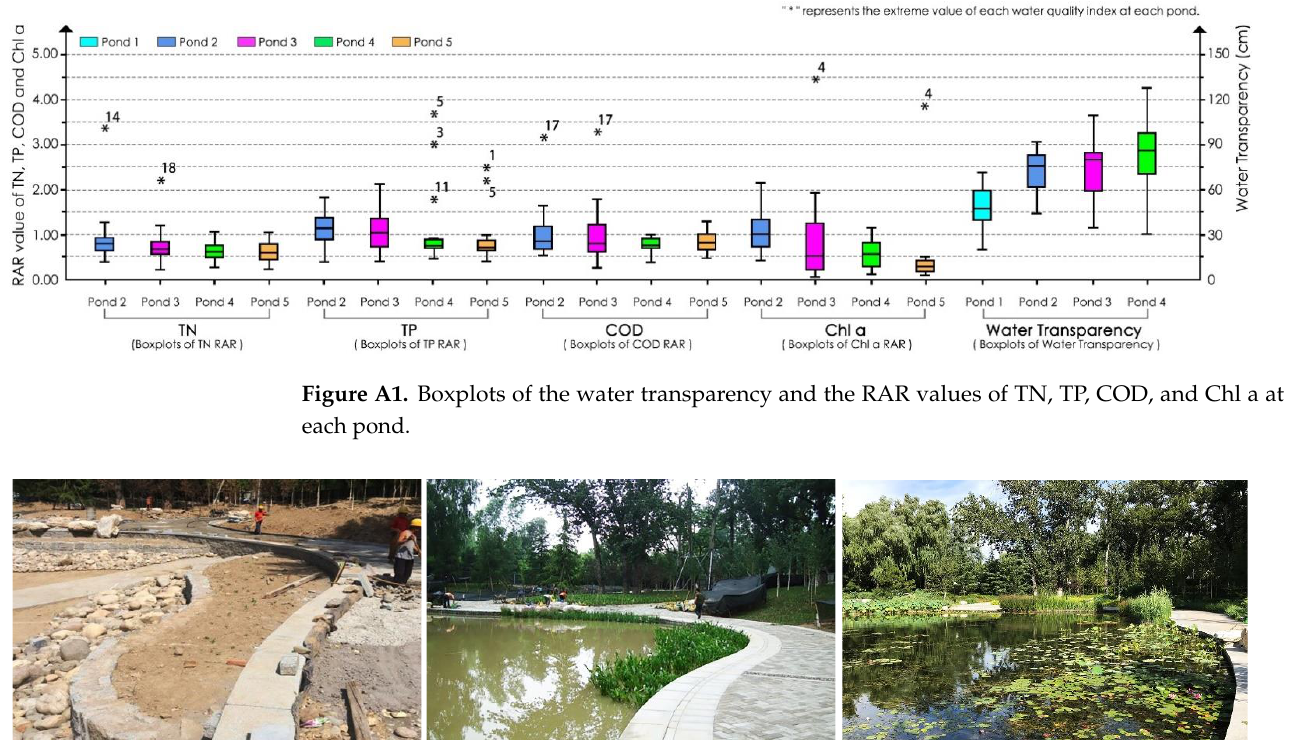
the other remediated ponds, these extreme values were considered to exceed the normal range. Because the experimental ponds were outdoors, there were many uncontrollable environmental factors. Therefore, these extreme values may have been caused by uncontrollable environmental factors at individual ponds in short time periods (such as surface runoff pollution) or by uneven distribution of the water bodies when collecting the water samples. As a consequence, these factors were deleted to prevent them from affecting the analyses. Extreme RAR values are also shown in the boxplot of Appendix B (Figure A1).